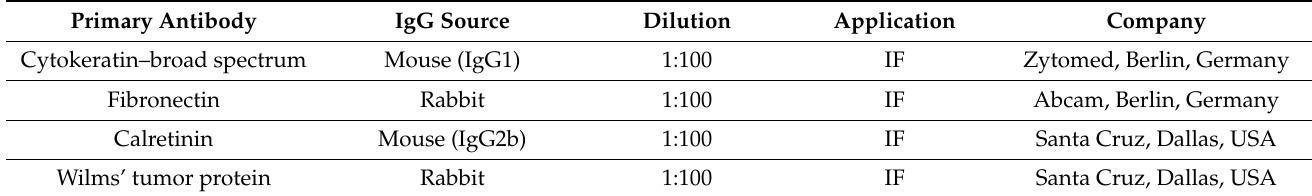
Table 1. Mesothelial cell